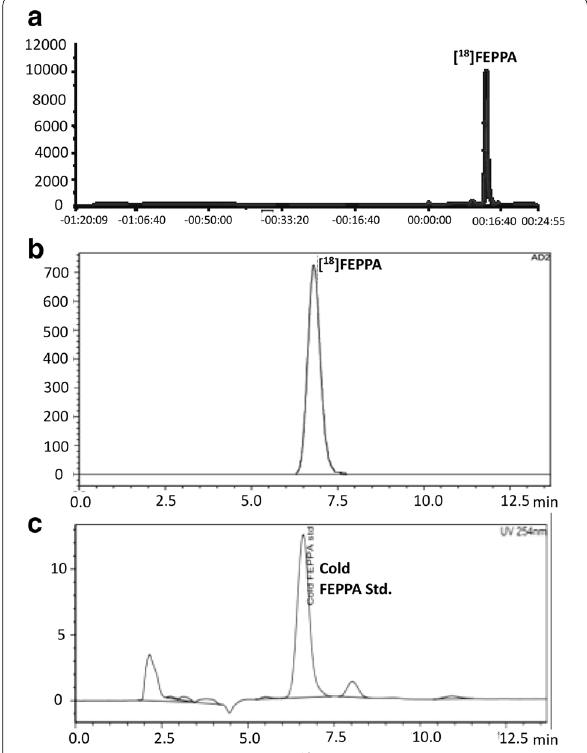
Fig. 1 a The retention time (Rt) of [ 18 F]FEPPA in semi‑preparative HPLC analysis was 13.07 min. b The retention time (Rt) of [ 18 F]FEPPA in HPLC analysis was 6.8 min. c The retention time (Rt) of authentic FEPPA in HPLC analysis was 6.6